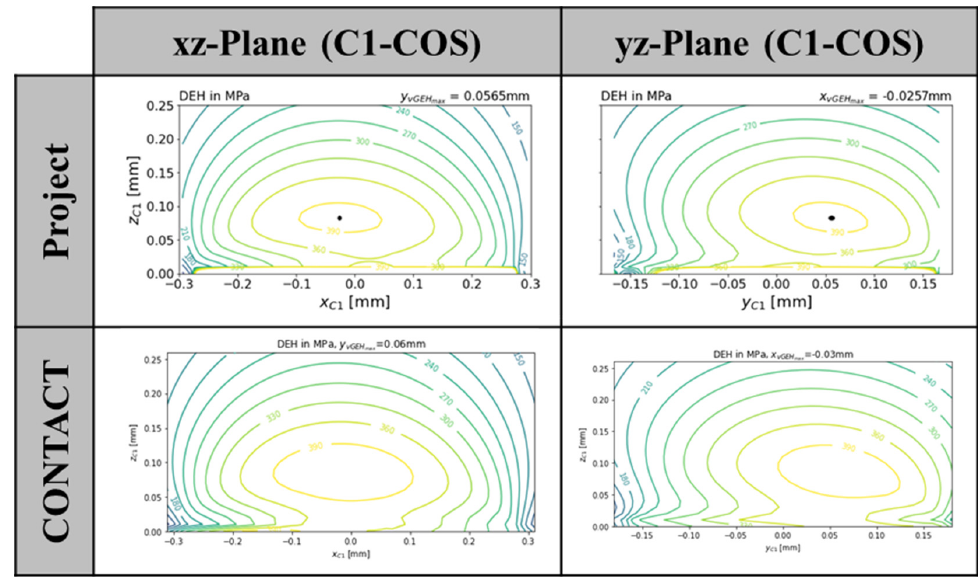
Figure 11. Equivalent stresses, steel/steel, 𝐹 (cid:2928)(cid:2911)(cid:2914) = 200 N , 𝐹 (cid:2911)(cid:2934) = 30 N , 𝜇 = 0.3 , 𝐹 (cid:2897)(cid:2925)(cid:2930)(cid:2925)(cid:2928) = −30 N , C1.